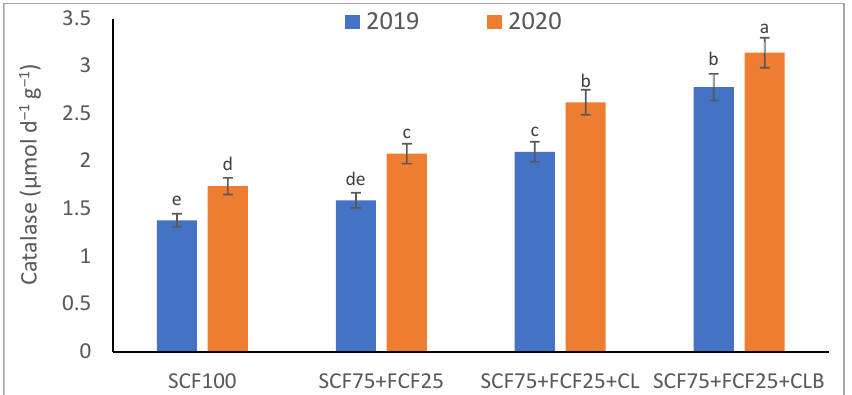
12 of 23 12 of 23